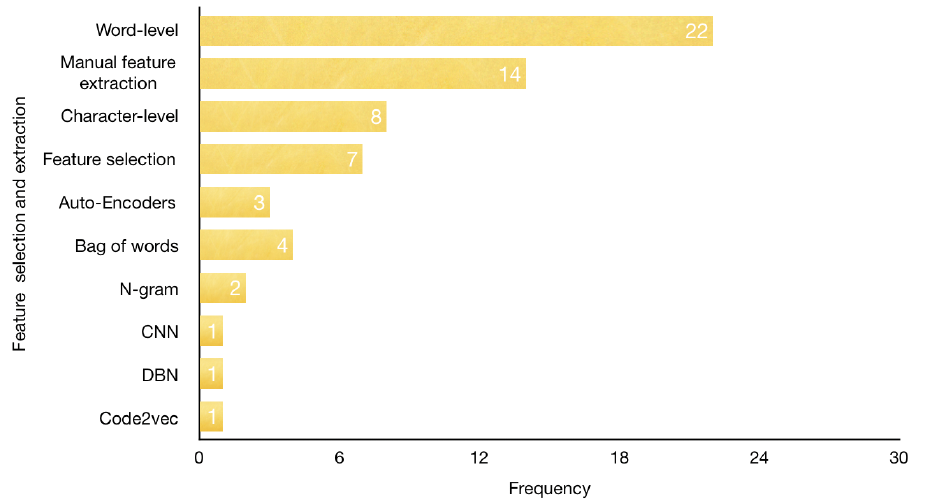
Figure 13. Histogram of feature selection and extraction methods used in selected